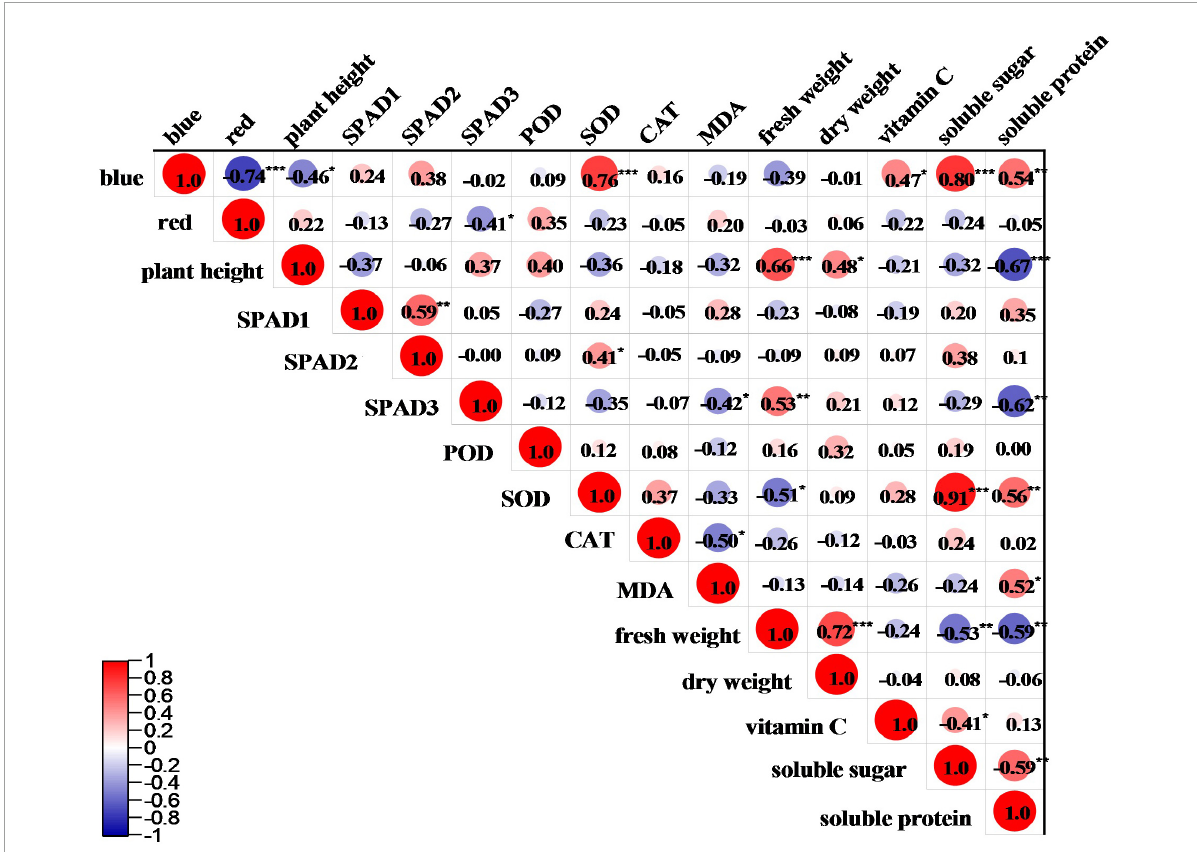
FIGURE5 Correlation analysis between different light qualities and various indicators of pea sprouts. *, **, and ***Denote significant differences at P ≤ 0.05, P ≤ 0.01, and P ≤ 0.001 of different species. Numbers are correlation coefficients. SPAD1, SPAD2, and SPAD3 denote upper first leaf, upper second leaf, and upper third leaf. Blue and red, respectively, represent the percentage of blue and red